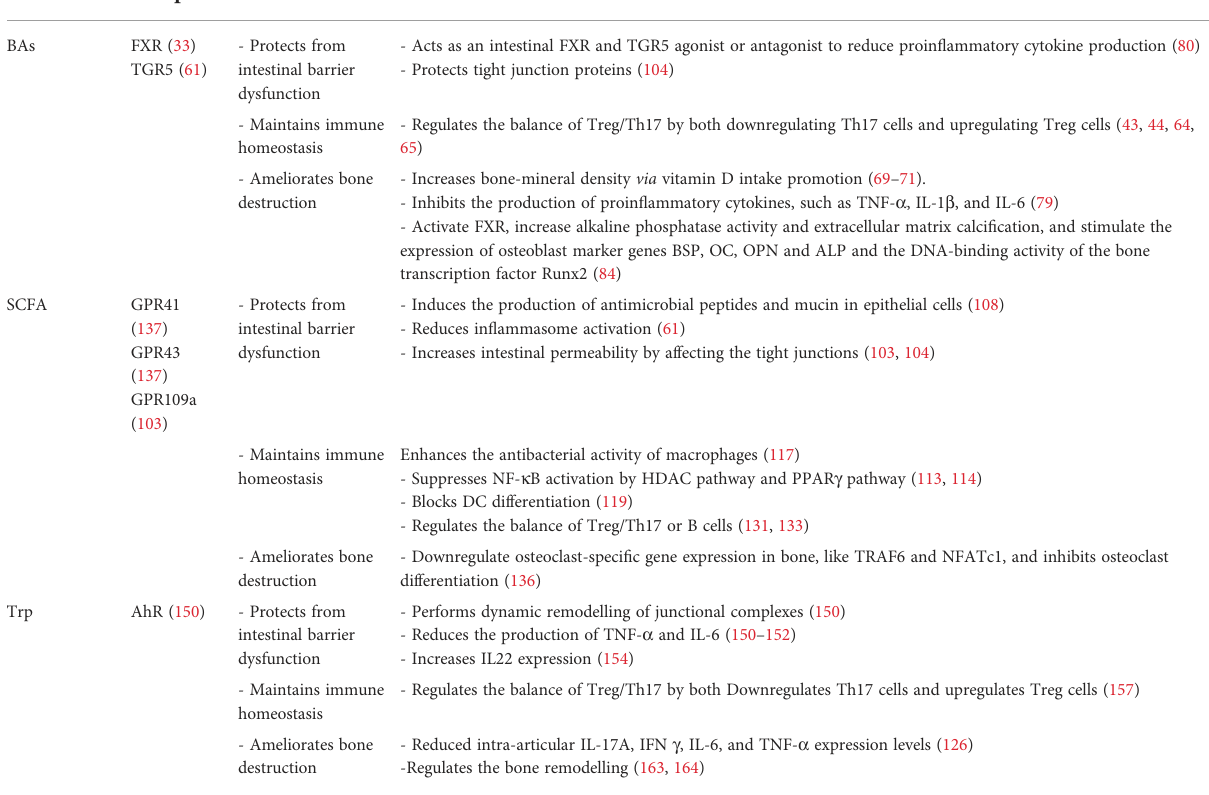
TABLE 2 Mechanisms of gut microbial metabolites in